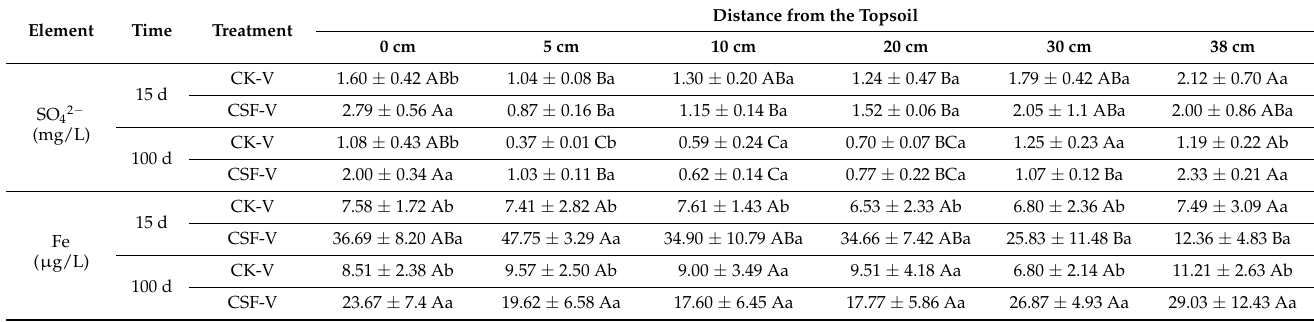
Table 5. The concentrations of SO 42 − and total Fe in different vertical soil layers with CSF